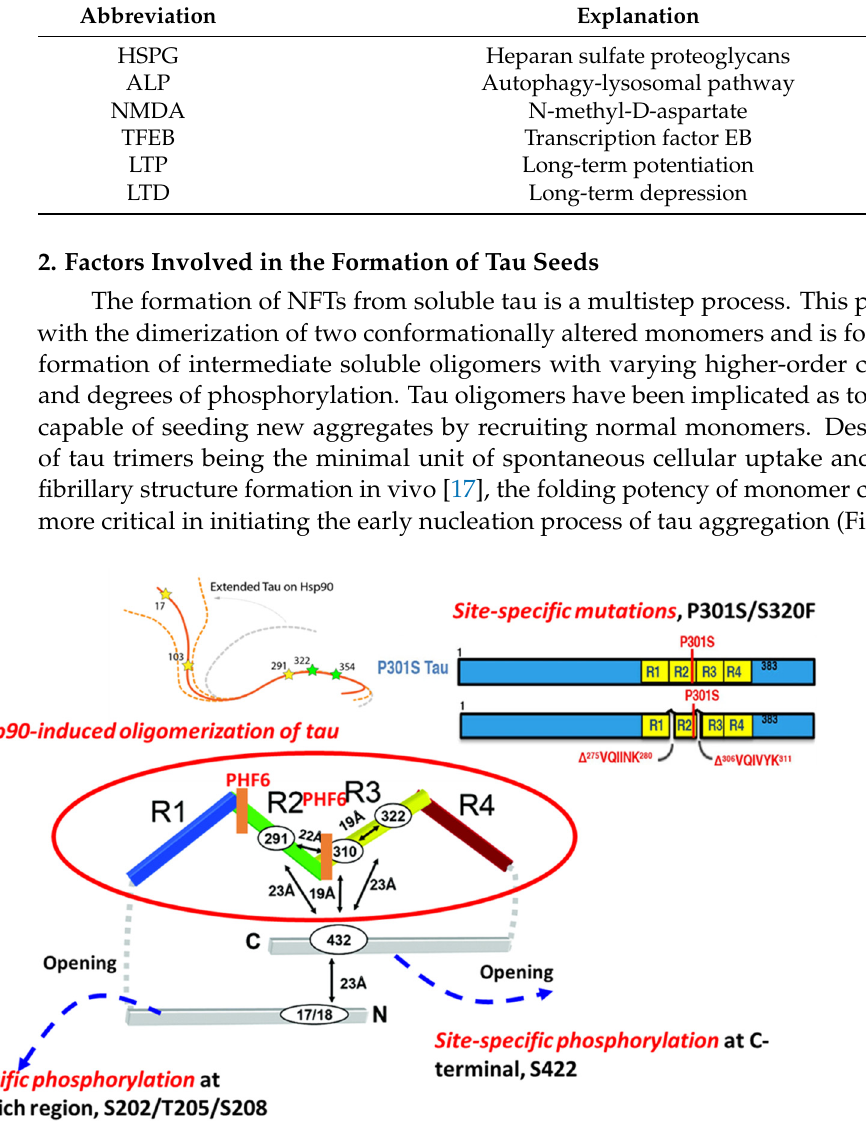
Figure 1. The molecular mechanisms involved in tau aggregation. Molecular factors such as site-specific phosphorylation, site-specific mutations on MAPT, and specific chaperones (Hsp90) are associated with tau aggregation.